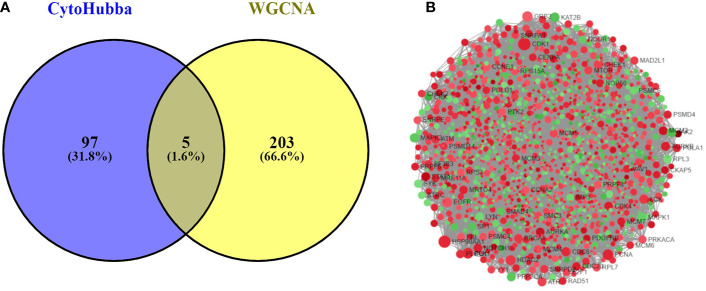

(A) Venn diagram demonstrates overlapping genes of the DEG-PPI network and WGCNA. (B) DEG-PPI network complex (upregulated genes showed in green; downregulated genes showed in red).